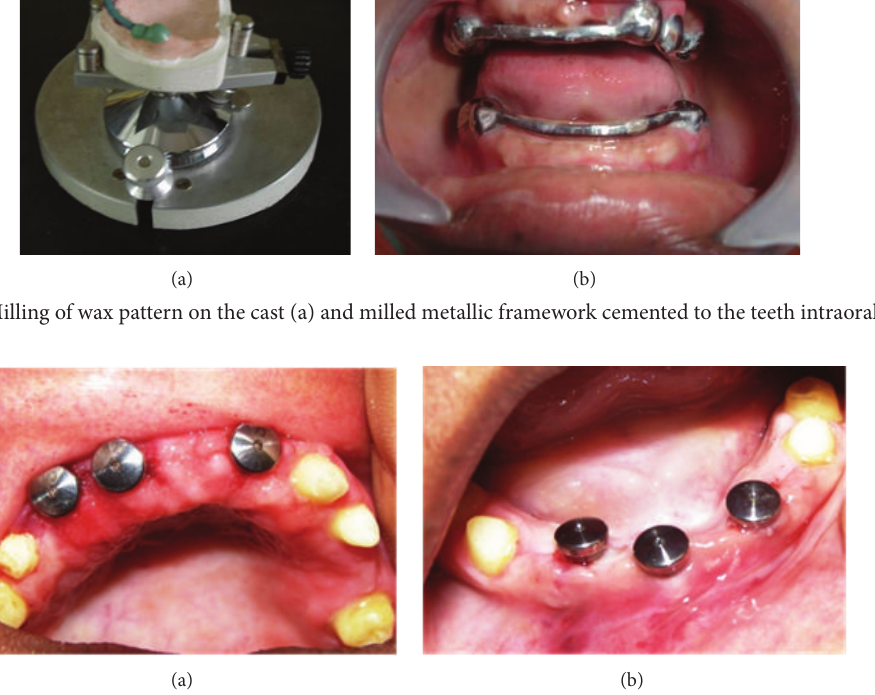
Figure 7: Implants in maxillary (12, 13, and 21 regions) (a) and mandibular (41, 43, and 32 regions) (b) with attached gingival formers.